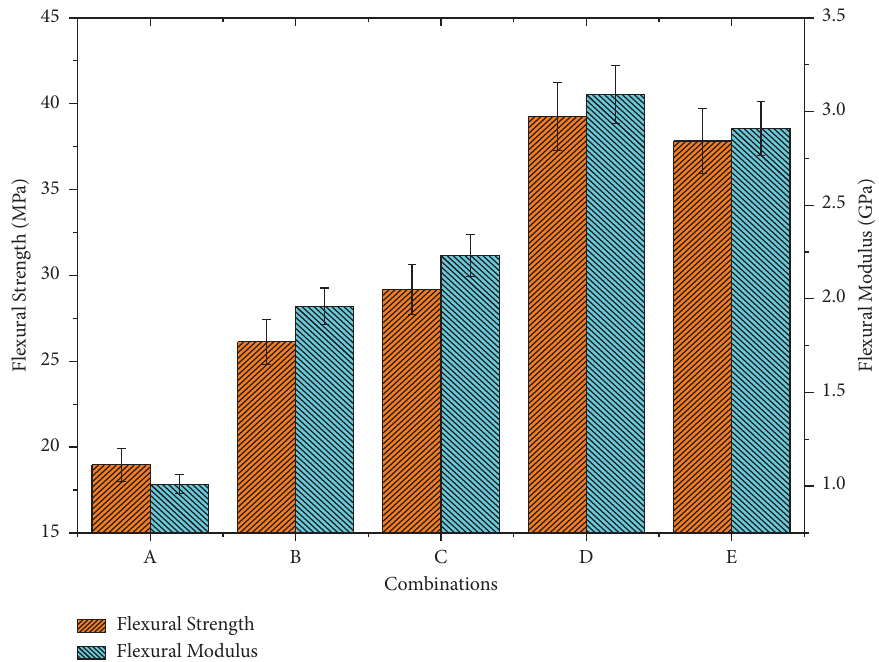
Figure 4: Bending strength and its modulus of FeO/Kevlar/epoxy based hybrid